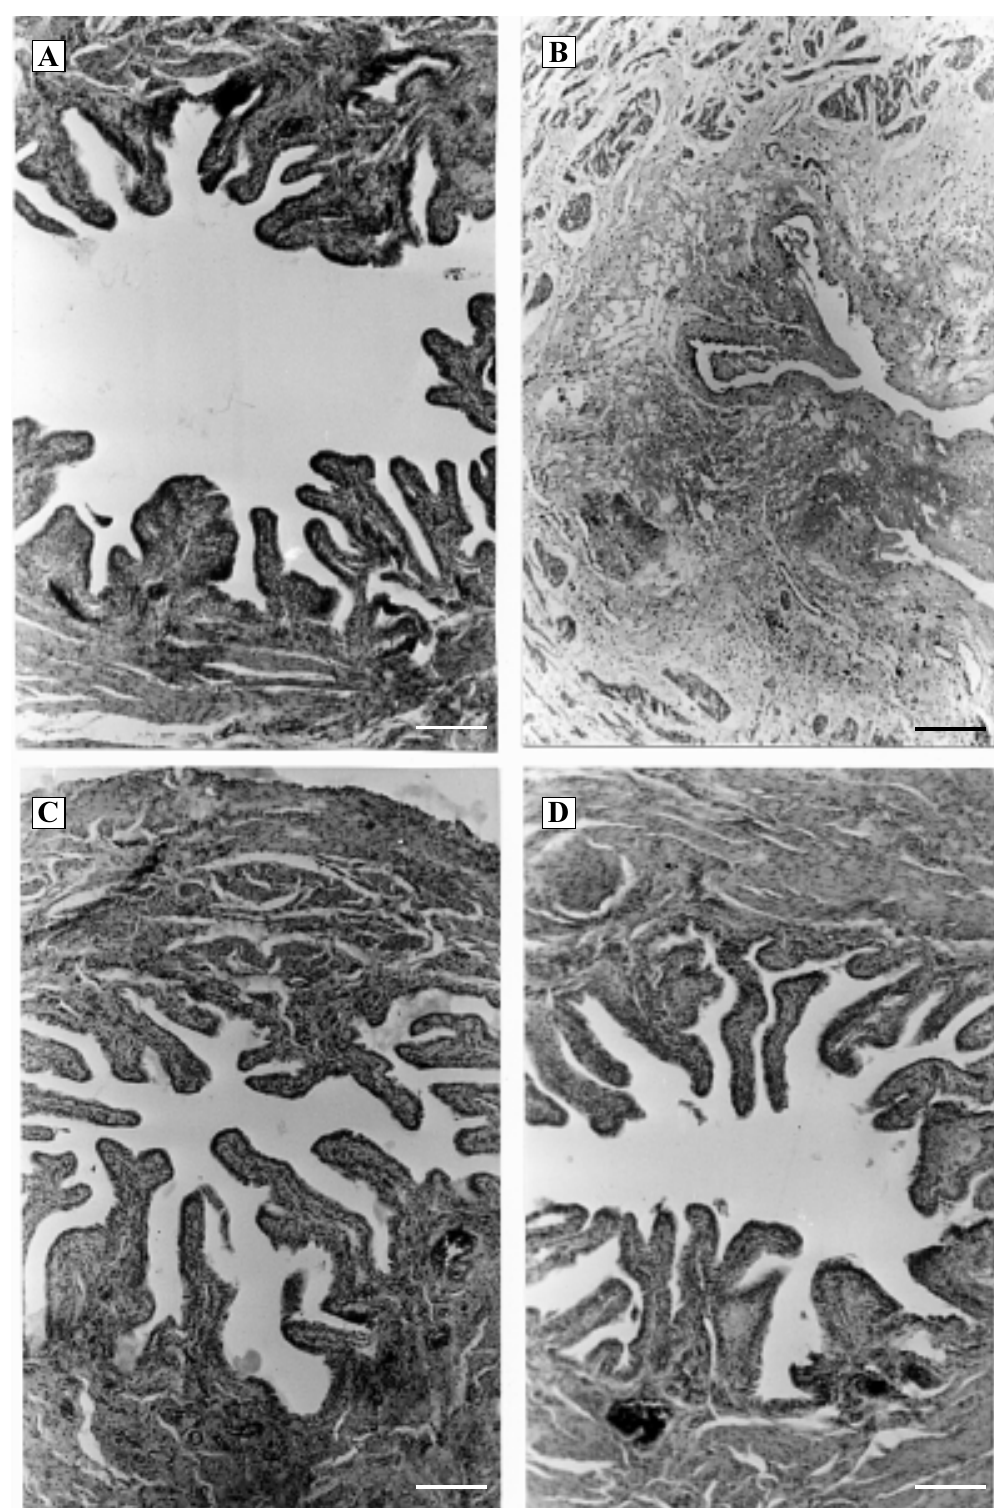
Figure 2 - Histological analy- sis of representative bladder walls in cross section. A , Nor- mal bladder. B , Cystitis in a rat treated 24 h previously with cyclophosphamide (200 mg/kg, ip) . Intense urothelial damage, edema, leukocyte infiltration, hemorrhage and fibrin deposition. C , Bladder of rats treated with 3 doses of Mesna (20% of cyclophos- phamide dose, 40 mg/kg, ip ). Urothelium preservation and absence of edema, hemor- rhage, leukocyte infiltration and ulcerations. D , Bladder of rats treated with 1 dose of Mesna and 2 doses of dexa- methasone (1 mg/kg, ip ). Ab- sence of microscopic alter- ations, comparable to the treatment with 3 doses of Mesna. Hematoxylin-eosin, X40. Bar, 250